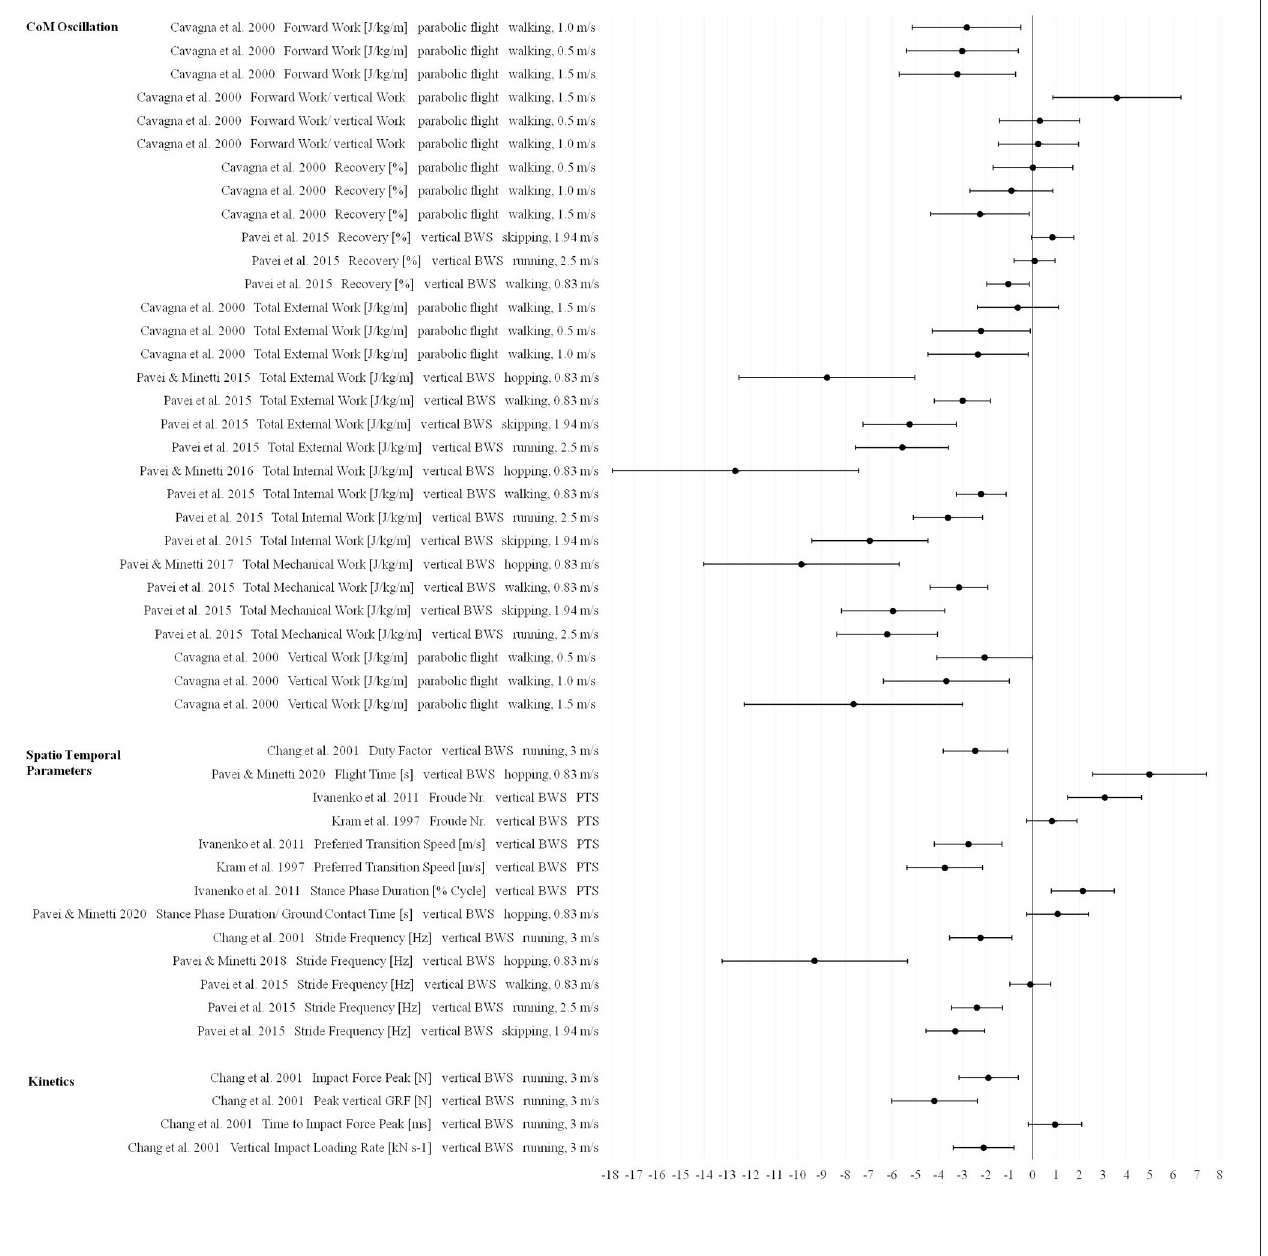
FIGURE 9 | Effect sizes (Hedge’s g) and confidence intervals for biomechanical parameters in Martian gravity compared to